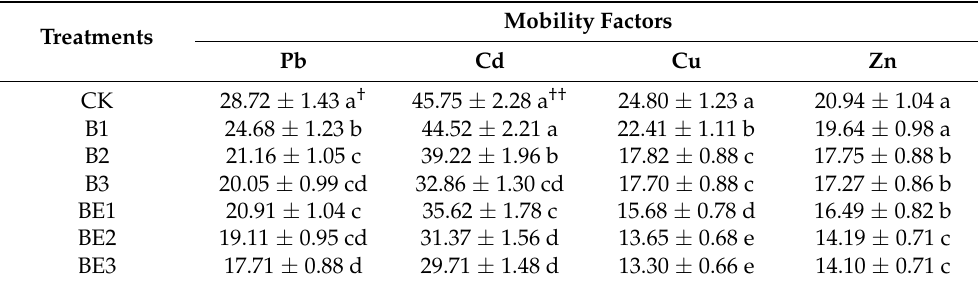
Table 4. Mobility factors of heavy metals in industrial sludge for different treatments. Mobility Factors Treatments Pb Cd